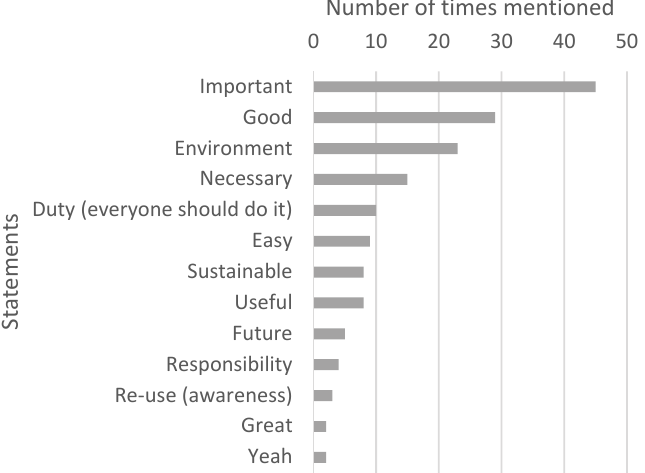
Figure A6. Opinion on recycling in three words, all positive statements mentioned more than once, first survey (106 individuals).